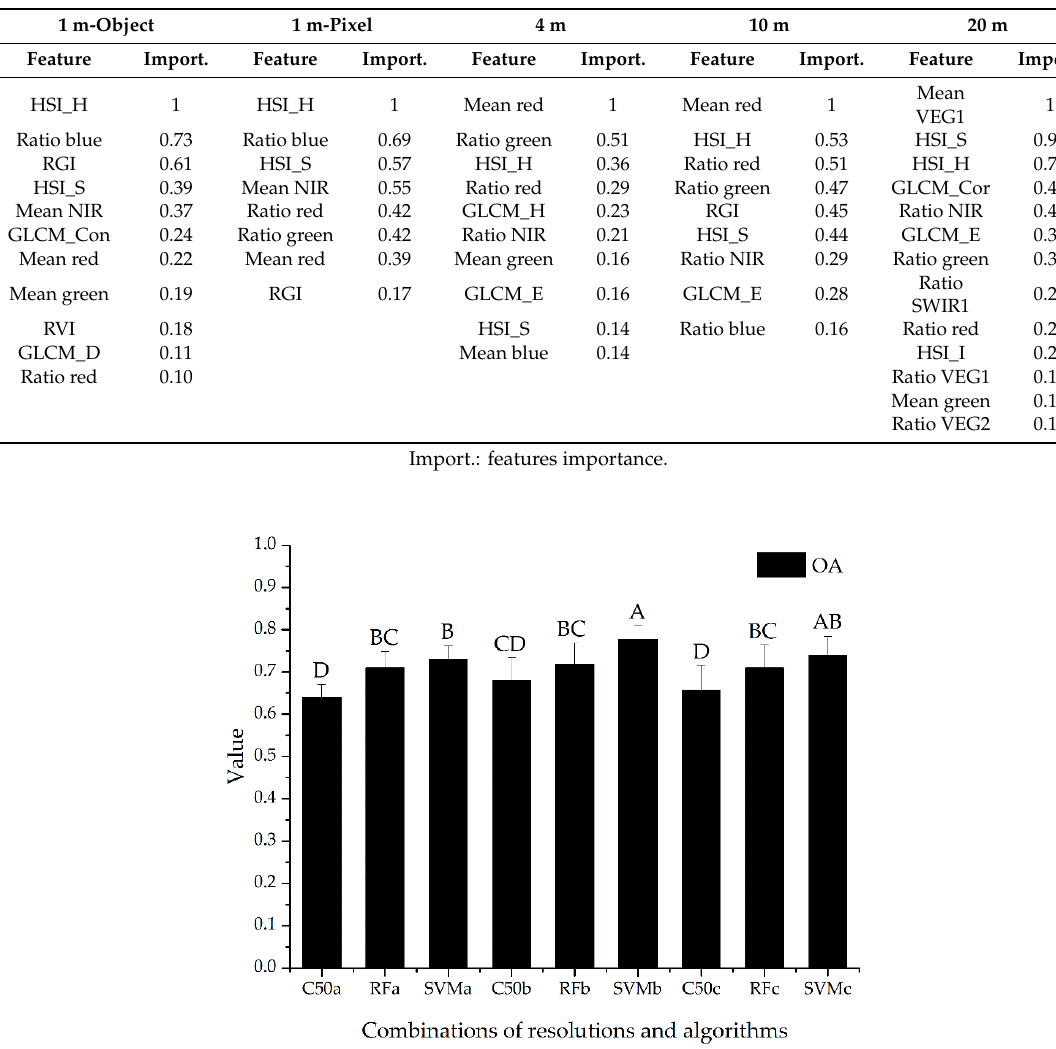
Table 4. Summary of features selected from GF2 and S2 images.